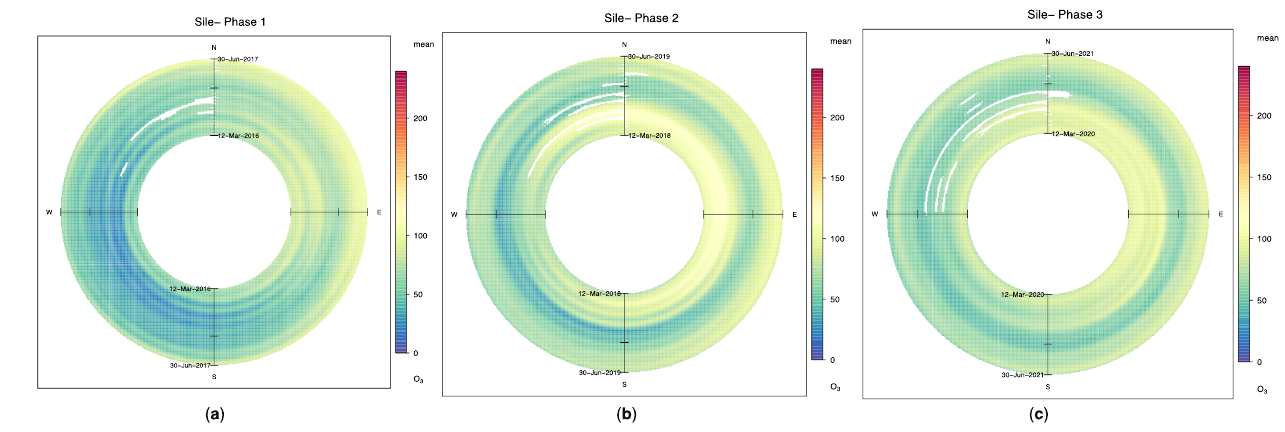
Figure 6. Directional trends of O 3 ( µ g/m 3 ) for Sile station: ( a ) Sile station O 3 ( µ g/m 3 ) trends for Phase I; ( b ) Sile station O 3 ( µ g/m 3 ) trends for Phase II; ( c ) Sile station O 3 ( µ g/m 3 ) trends for Phase III.